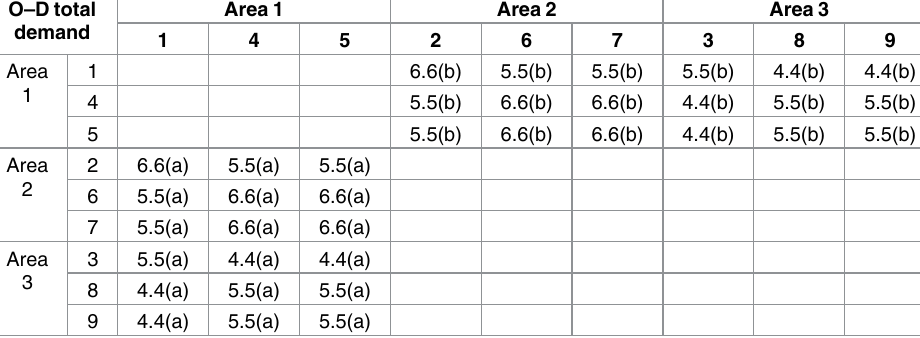
Table 1. O–D total demand and corresponding probability density distributions (unit: thousand persons).